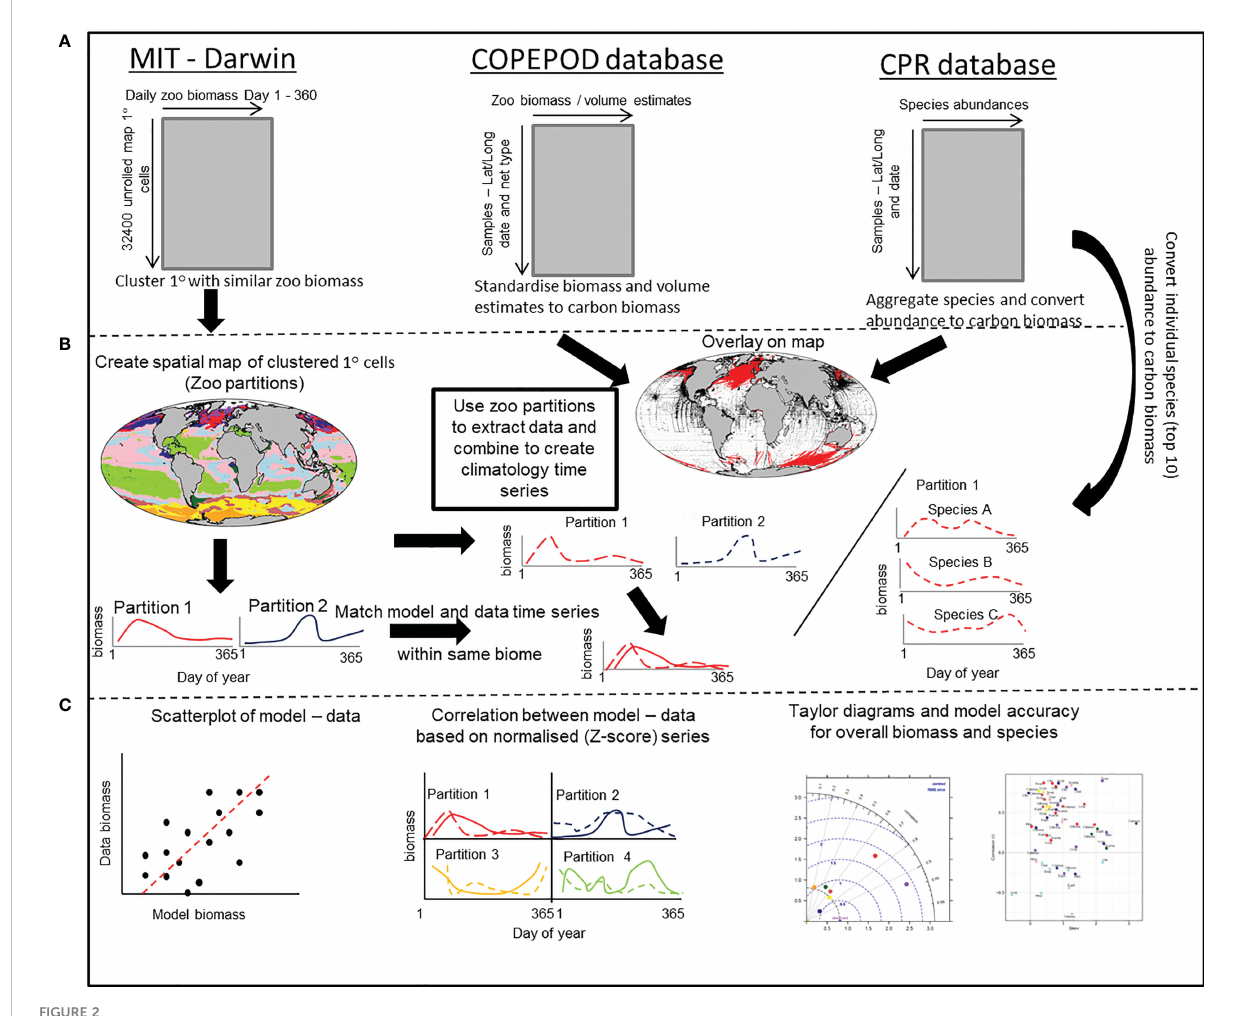
FIGURE 2 A schematic that outlines the stepwise procedure for comparing modelled and in-situ mesozooplankton carbon biomass. (A) Shows the structure of the MIT-Darwin model data and the COPEPOD and CPR database that contain the in-situ biomass and count data. (B) The MIT-Darwin data are clustered into regions with similar characteristics of zooplankton annual cycle. Both COPEPOD and CPR database data are standardized to the same metric of carbon biomass derived from MIT-Darwin. The partitions are used to extract data and are averaged within each partition to create a time series of in-situ data that matches the model data estimated within each partition. A similar process is performed for the most abundant (Top 10) species found within the CPR database and treated in the same way. (C) The model and in-situ time series within each of the partitions are compared and contrasted by using a simple scatterplot, correlation of normalized data and taylor diagrams to assess model accuracy. For the individual species, only the correlation and model accuracy is